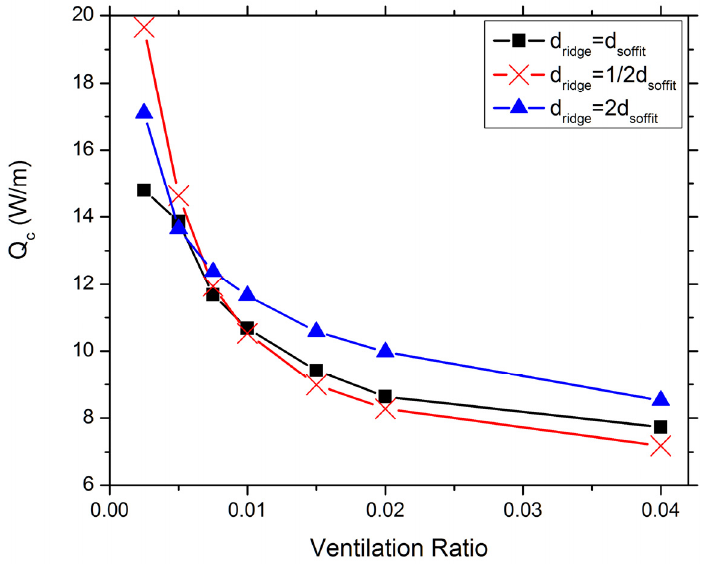
Figure 8. Predicted attic cooling load as a function of ventilation ratio for balanced and unbalanced attic ventilation